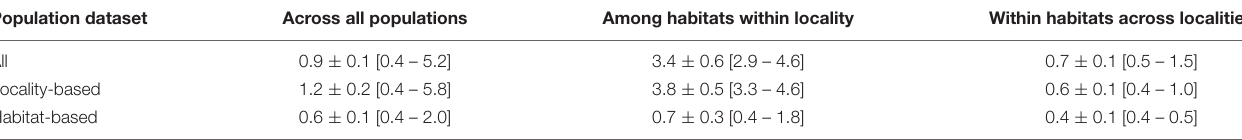
TABLE 2 | Average estimates of bidirectional migration rates among populations of Espeletia . Population dataset Across all